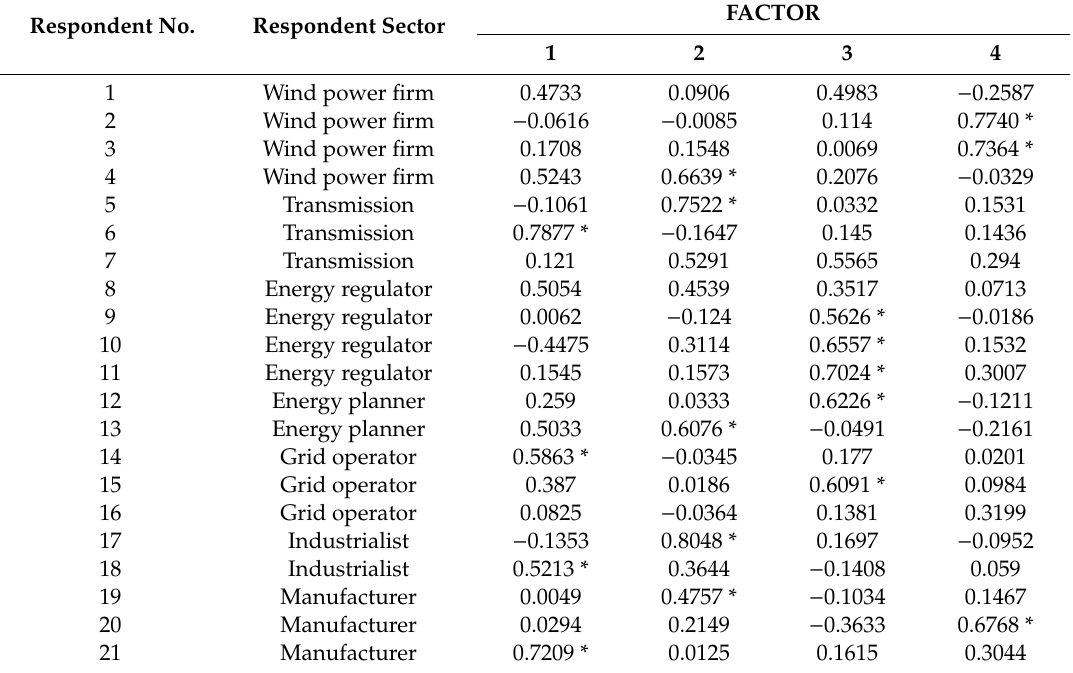
Table 4. Rotated factor loadings (* indicates defining sort) with respondent type summarized. Respondent